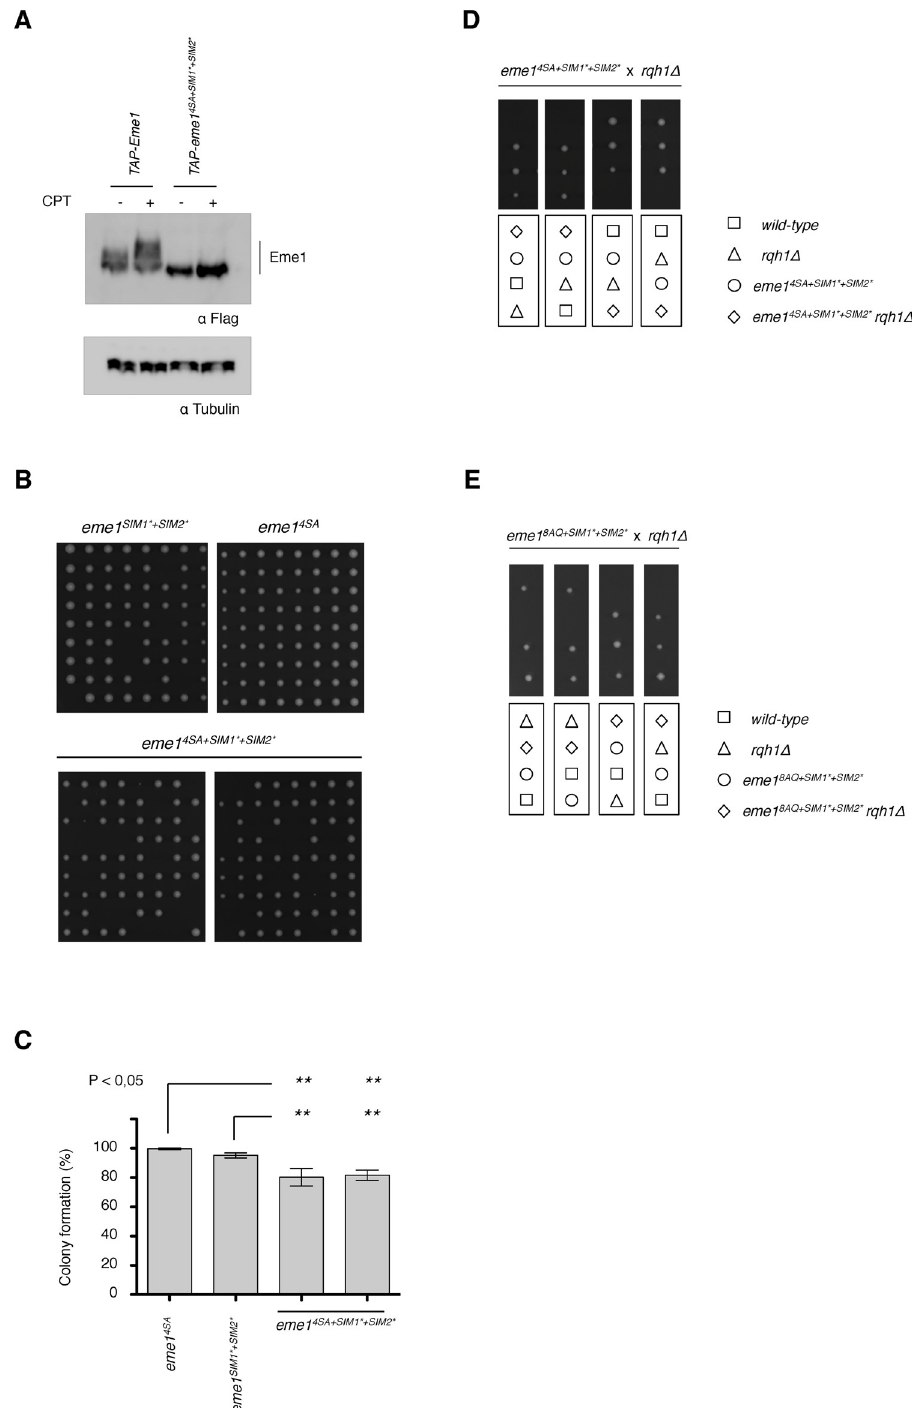
Fig 7. The combined loss of Eme1 phosphorylation and SUMO-binding properties is lethal in absence of Rqh1 BLM . A- Western blot detection of TAP-Eme1 on total lysates from untreated or 40 μ M CPT–treated from WT or eme1 4SA+SIM1 � +SIM2 � cells. An Eme1 4SA+ SIM1 � +SIM2 � protein shows no constitutive Cdc2 CDK1 -dependent (-CPT) and DNA damage-induced mobility shift (+CPT). Tubulin is used as a loading control. Note: TAP- = 2xProtA-TEVsite- 2xFlag- B- Exponentially growing eme1 SIM1 � +SIM2 � , eme1 4SA and eme1 4SA+SIM1 � +SIM2 � cells were seeded on YES plates by micromanipulation and allowed to grow for 3 days at 32˚C. C- Average percentage ( ± s.d.) of viable colonies (n = 3 independent experiments). Statistical significance is measured with one-way ANOVA followed by Tuckey post-test. D-